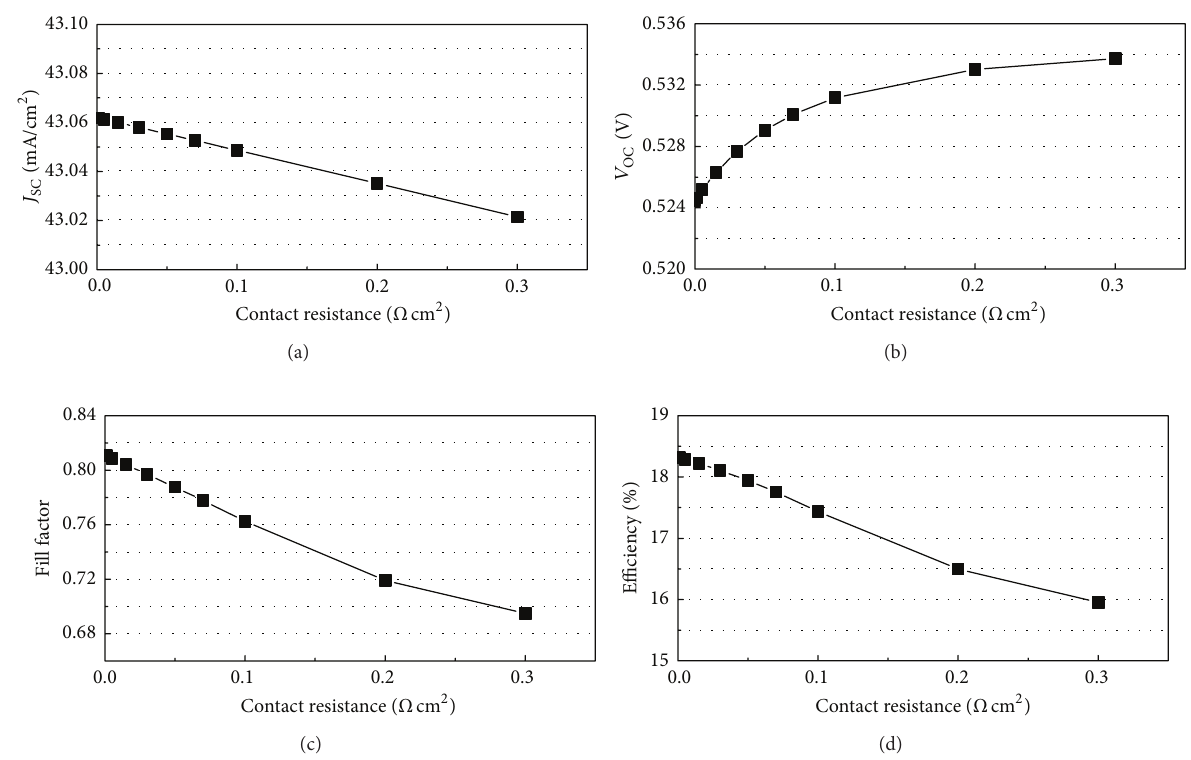
Figure 4: Dependence of the output parameters: (a) short circuit current density, (b) open circuit voltage, (c) fill factor, and (d) efficiency of the cell, on the contact resistance. The doping concentration of boron was set as 5 × 10 18 atoms/cm 3 .